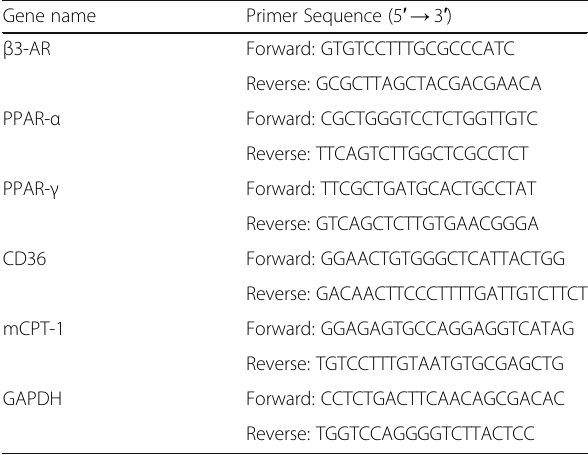
Table 1 Primers for real-time